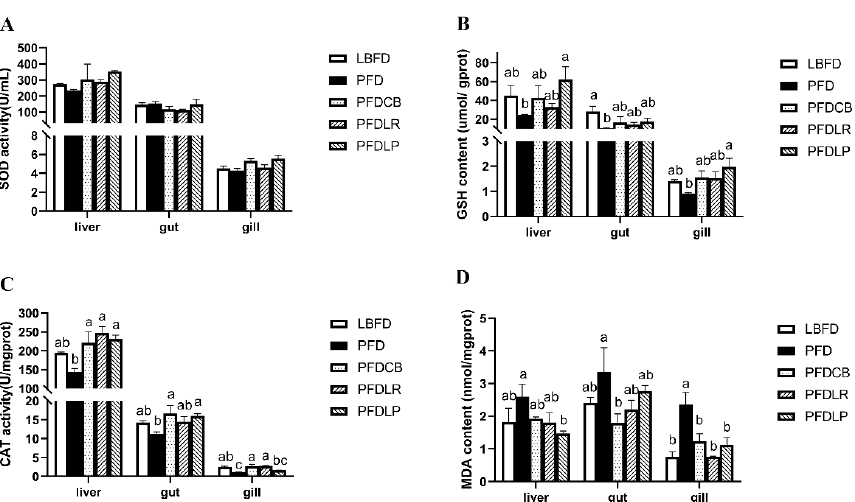
Figure 5. Activities of SOD ( A ), GSH ( B ) and CAT ( C ) and content of MDA ( D ) in the gut, liver and gills of mandarin fish in different feeding groups (LBFD, PFD, PFDCB, PFDLR and PFDLP) after being fed for 28 days. Data are presented as mean ± SEM ( n = 9). Abbreviations: SOD, superoxide dismutase; GSH, glutathione; CAT, Catalase; MDA, malondialdehyde; LBFD, live bait fish feeding group; PFD, pellet-feed feeding group with probiotics free; PFDCB, pellet-feed feeding group with C. butyricum plus; PFDLR, pellet-feed feeding group with L. rhamnosus plus; PFDLP, pellet-feed feeding group with L. plantarum plus. A value followed by a lowercase superscript (a–c) differs significantly from all other values not followed by the same lowercase superscript at the same time point based on ANOVA followed by the post hoc test ( p < 0.05).